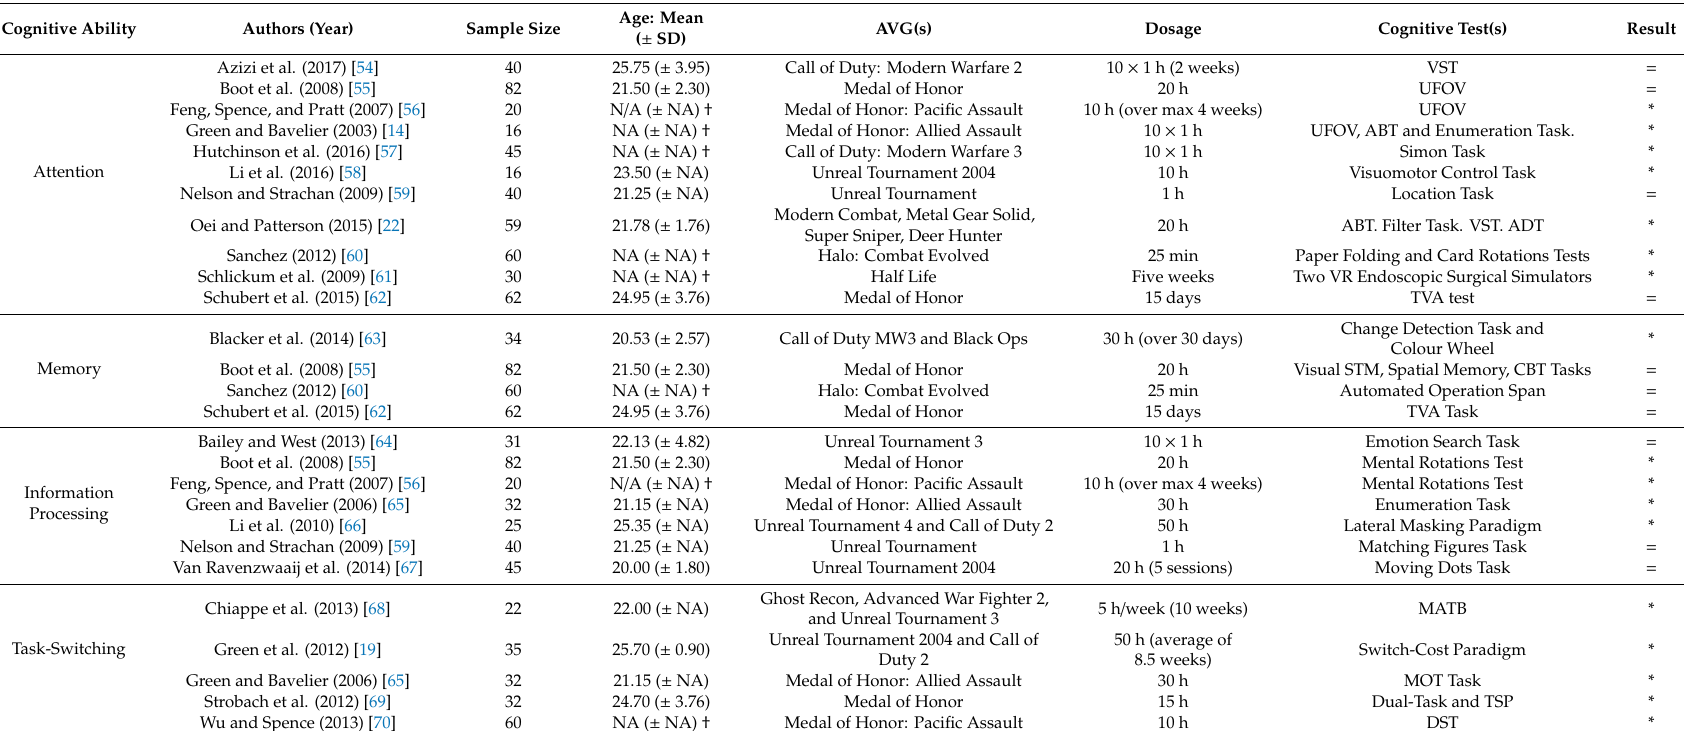
Table 1. Action video games (AVG) intervention study characteristics organised according to cognitive